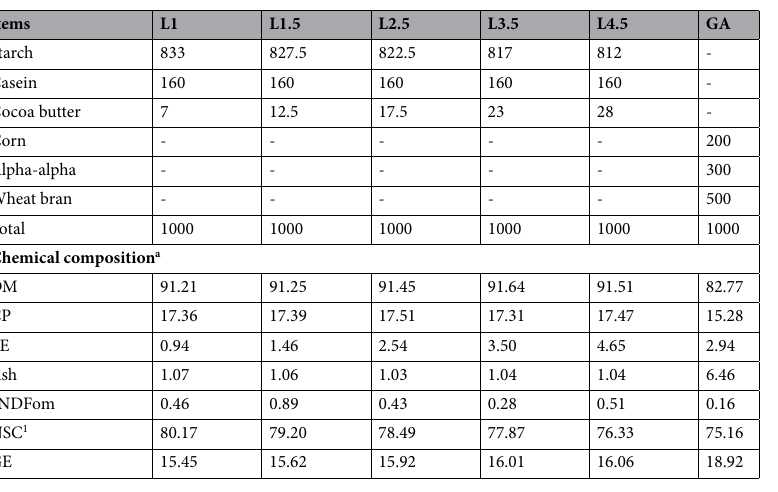
Table 6. Ingredients (g/kg, as is), chemical composition (g/100 g on DM) and gross energy (MJ/kg, on DM) of the 5 experimental substrates and the Gainesville diet. Legend : DM: dry matter, CP crude protein, EE ether extract, aNDFom amylase neutral detergent fiber organic matter, NSC non-structural carbohydrates, GE gross energy. a Values are reported as mean of duplicate analyses. 1 Calculated as 100 – (CP + EE + Ash +